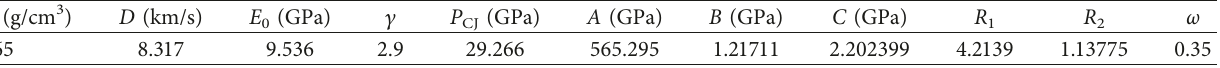
Table 4: Parameters of the JWL state equation of RDX charge.